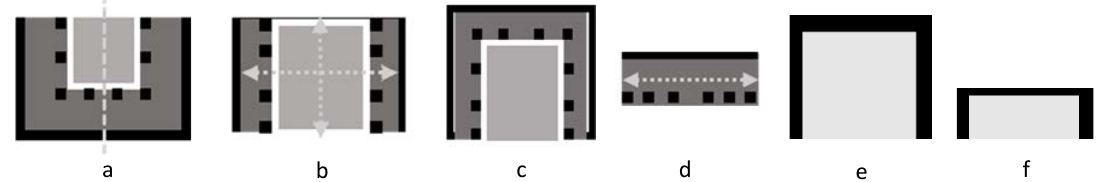
c Fig. 11: Evolution of the roofed space of portico, a- U-shaped portico: devotional, b- Linear portico: transition, c- U-shaped portico: transi - Fig. 11: Evolution of the roofed space of portico, a‐ U‐shaped portico: devotional, b‐ Linear portico: tion, d-Linear portico: transition, e- porch: devotional and educational, f- porch: pre-entrance transition, c‐ U‐shaped portico: transition, d‐Linear portico: transition, e‐ porch: devotional and